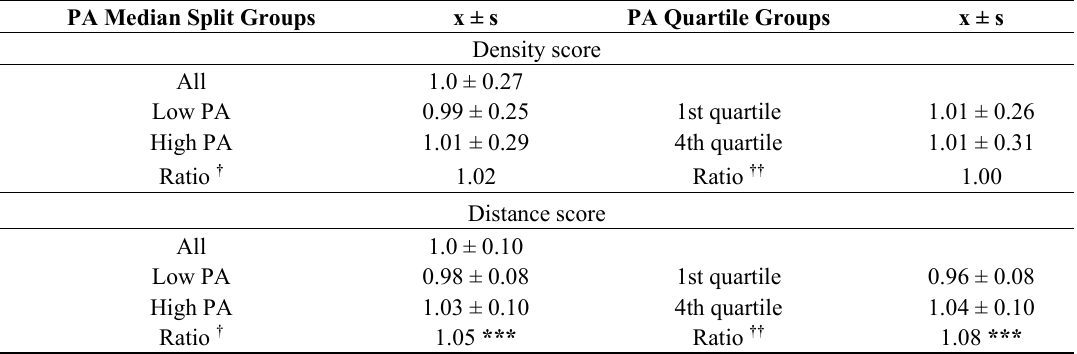
Table 4. Results of independent t-test for the relative transport and recreation PA differences (overall median split; 1st quartile vs 4th quartile) in the relative perception of the themes of the neighbourhood environment (mean ± standard